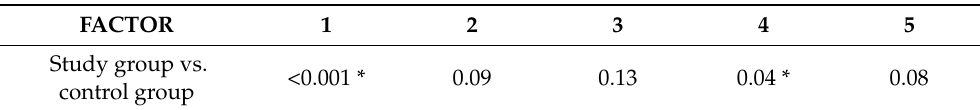
Table 4. The level of statistical significance between the groups for the factors of the Resilience Measurement Scale (Bonferroni